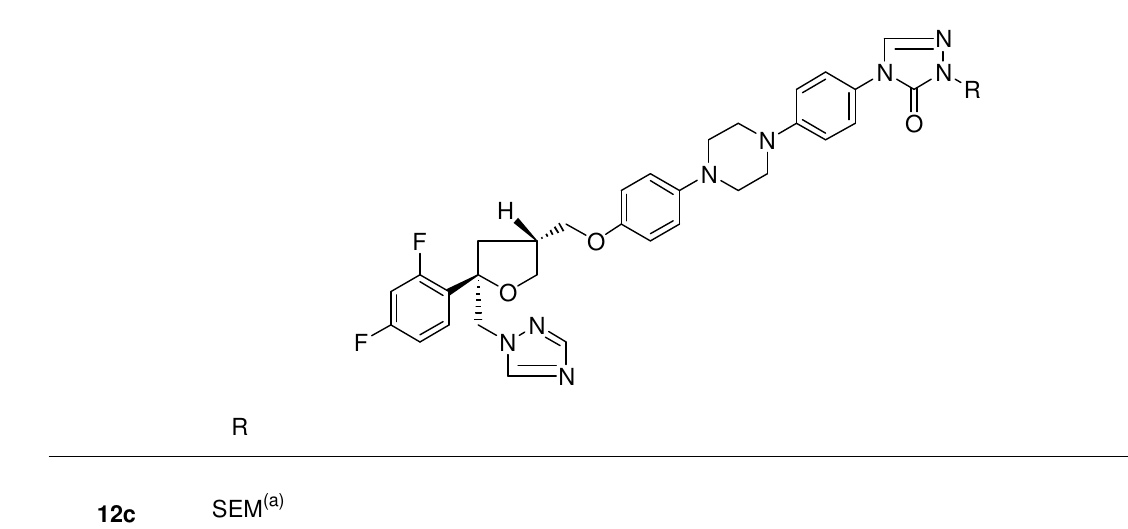
Figure 6. Posaconazole 12l and